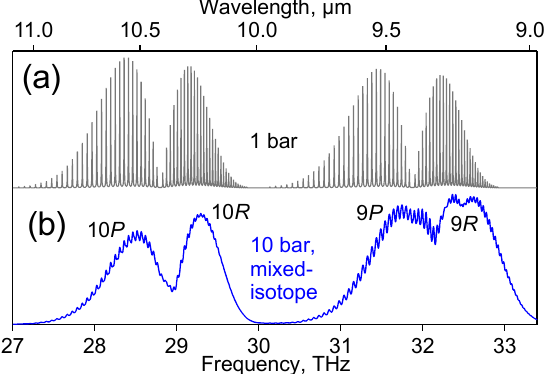
Fig. 1. Typical gain spectra of CO 2 lasers: (a) conventional atmospheric-pressure laser; (b) high-pressure, mixed-isotope C 16 O 2 - C 16 O 18 O - C 18 O 2 laser